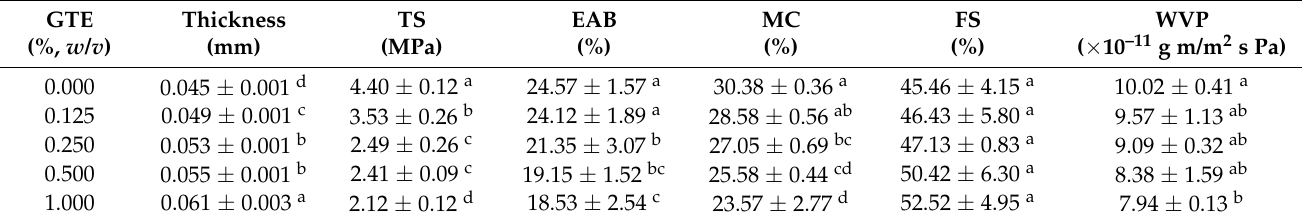
Table 3. Thickness, mechanical, physicochemical, and barrier properties of rice-starch-pectin films incorporated with green tea extract at different